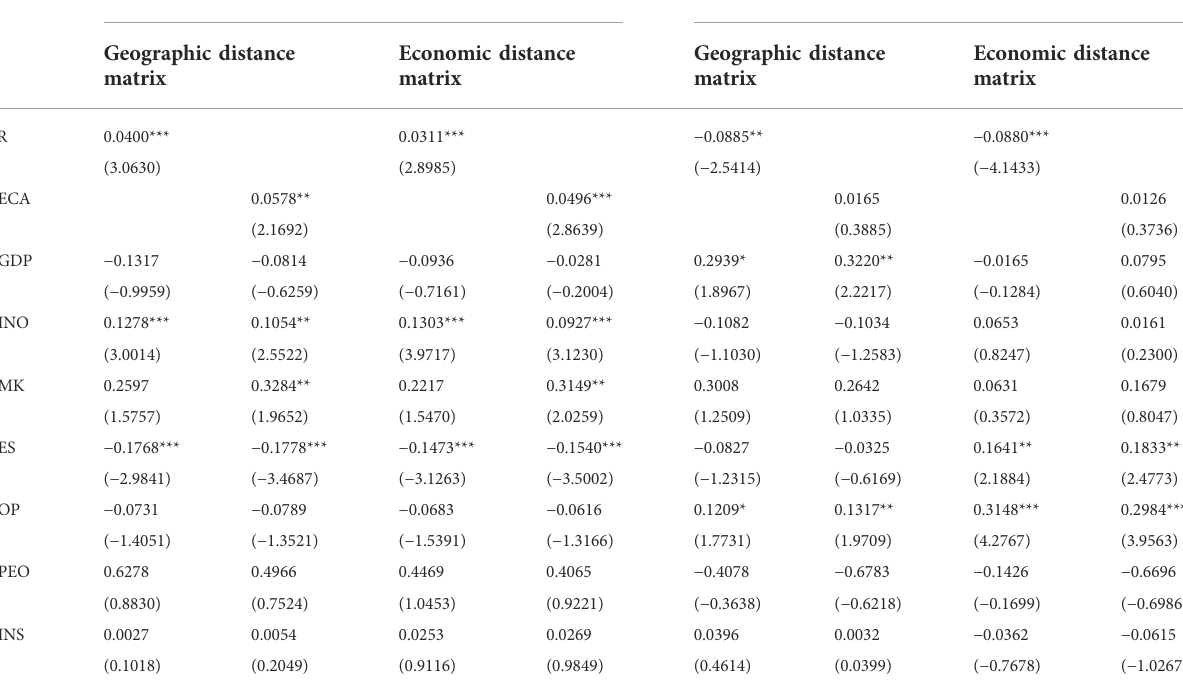
TABLE 6 Estimation results of decomposition